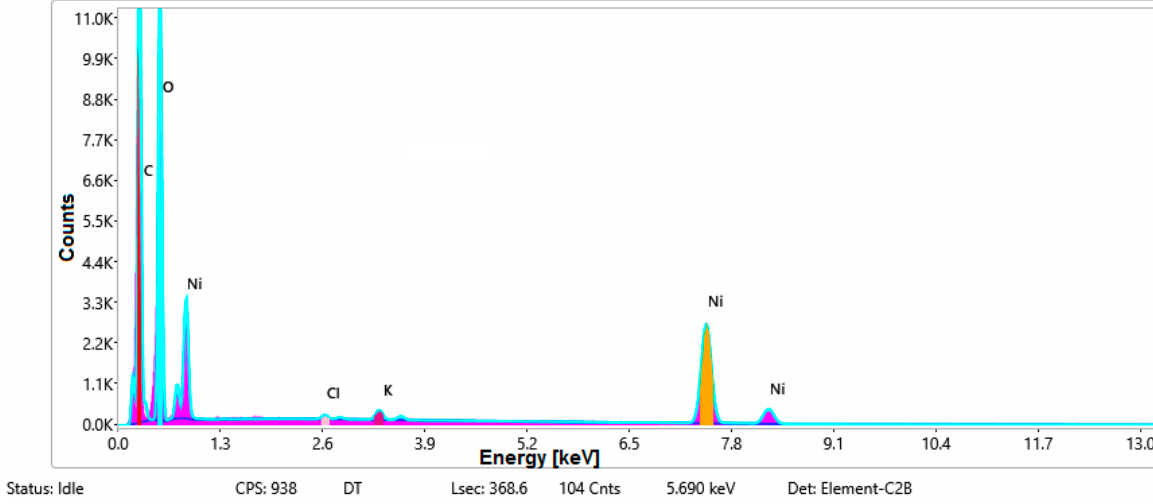
Figure 11. Smart elemental mapping overlay for sample S1 treated in RF plasma O 2 , using RF 2 generator and power 50 W and Ni paste.